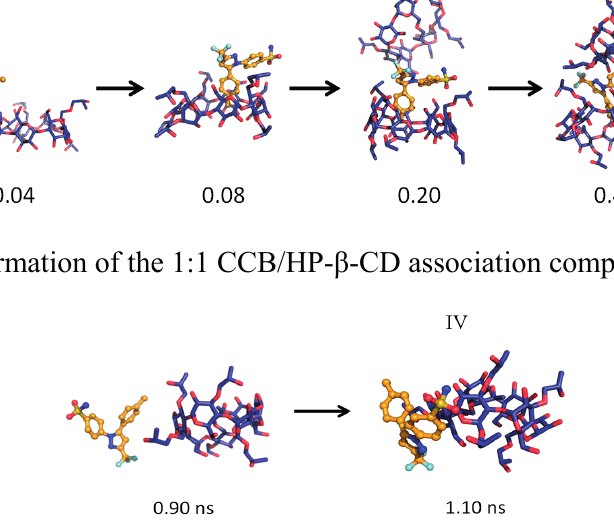
Figure 6. The distances between the centroids of CCB and HP- β -CD during the formation of inclusion complexes. Black: the formation of Complex I; Blue: the distance between the centroids of CCB and the first HP- β -CD during the formation of Complex II and, subsequently, the formation of Complex III; Red: the distance between the centroids of CCB and the second HP- β -CD during the formation of Complex III. The arrow points to the formation of Complex III via Complex